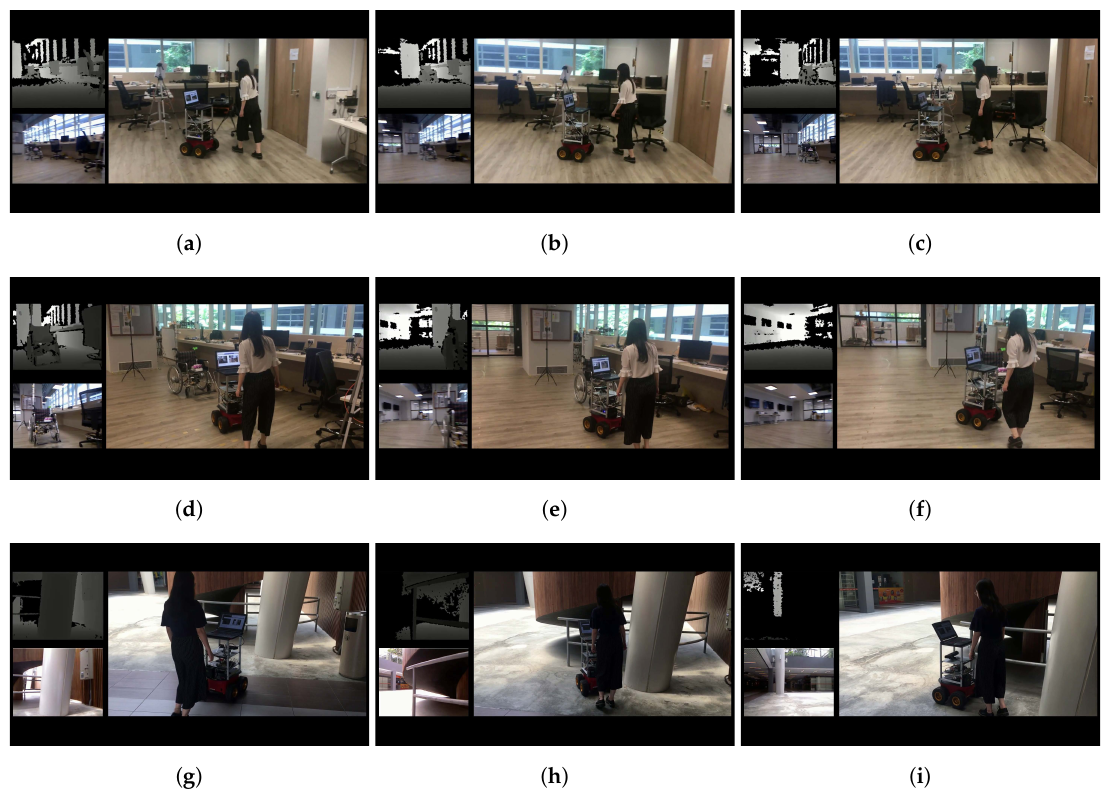
Figure 8. Examples in static environments. In each figure, the third-person view is shown on the right while the corresponding depth image and first-person view are displayed in the top and bottom left corners, respectively. ( a – c ) Illustrate the process to avoid colliding with a tripod. ( d – f ) Describe the process to avoid bumping into a wheelchair. ( g – i ) Demonstrate the process to avoid running into a